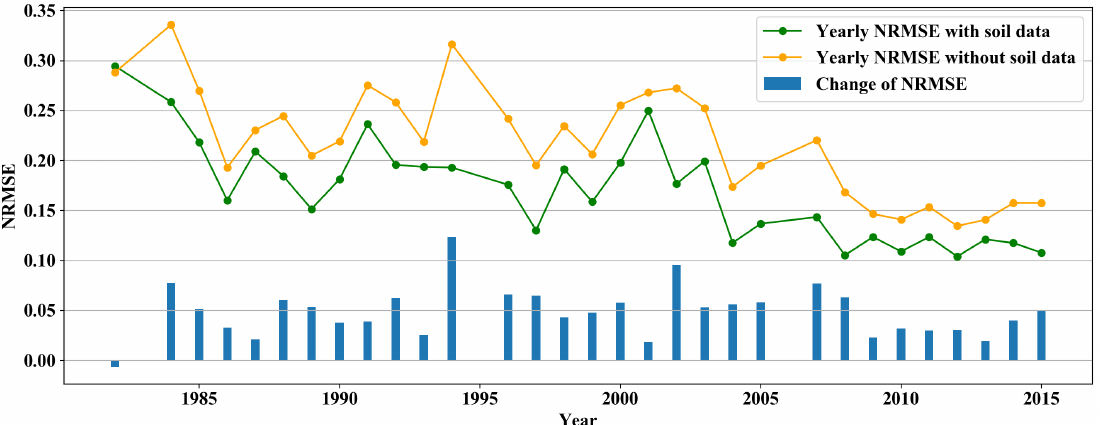
Figure 8. Effect of soil information on accuracy. “Change of NRMSE” is the improvement in NRMSE with the addition of soil data.